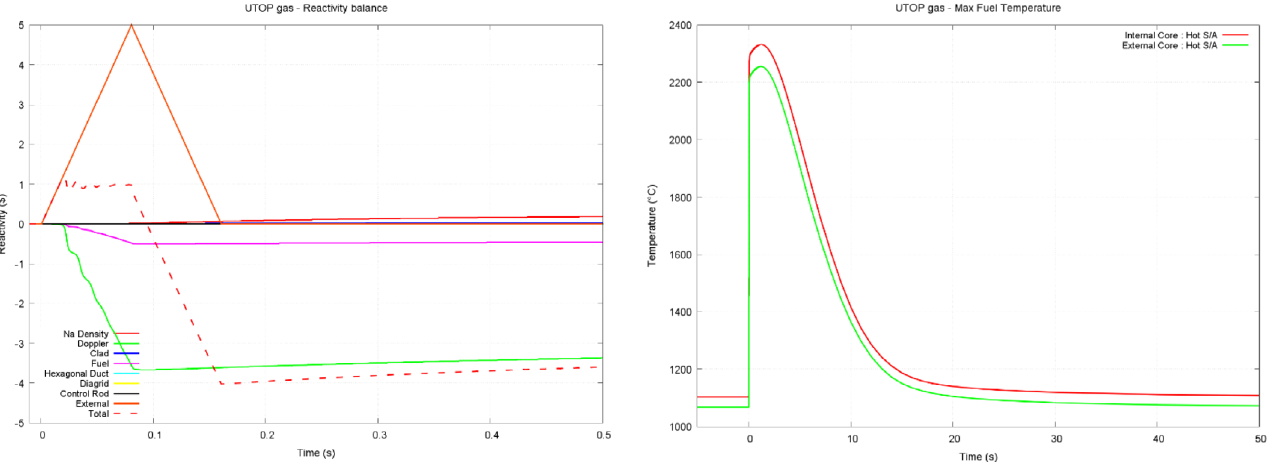
Fig. 6. UTOP maximal fuel temperature. Fig. 5. UTOP